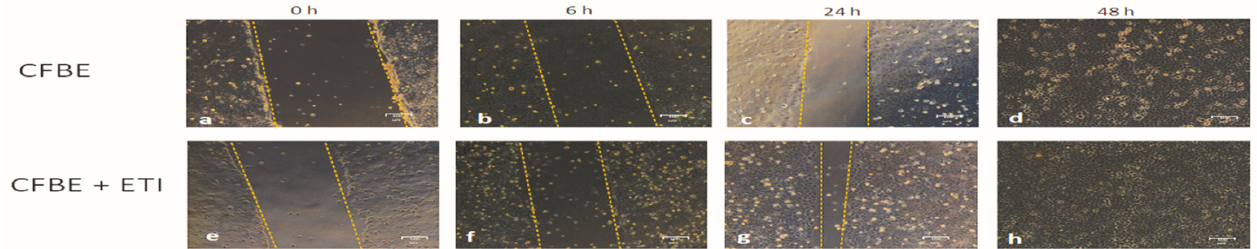
Figure 2. Wound closure in the presence of Elexacaftor/Tezacaftor/Ivacaftor (ETI) in CFBE F508del- CFTR cells. Wound repair was determined on CFBE F508del-CFTR ( a – d ), or CFBE F508del-CFTR with ETI treatment ( e – h ). Wound closure was evaluated at 0 h ( a , e ), 6 h ( b , f ), 24 h ( c , g ) and 48 h ( d , h ). Yellow dashed lines denote wound edges. Bar = 100 μ m.